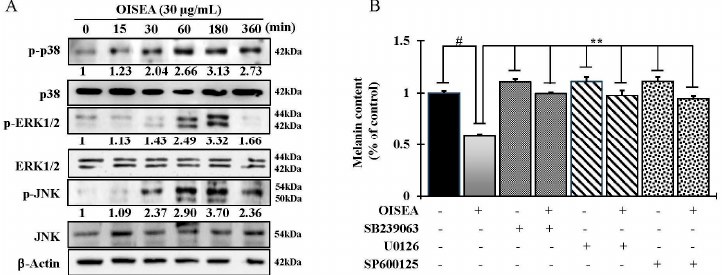
Figure 5. Effect of HLA on MAP kinase-dependent signaling in melan-a cells. ( A ) Cells (5 × 10 5 cells/mL) were cultured for 24 h, and the medium was replaced with fresh medium containing various concentrations of test compounds or arbutin for the indicated times. Phosphorylation of JNK, ERK, and p38 MAPK was analyzed using phospho-speci fi c JNK, ERK, and p38 MAPK antibodies. Equal protein loading was checked using β -actin antibodies. Numbers (each phospho-antibody) mean the relative band intensity. ( B ) OISEA was cotreated with selective inhibitors of p38 (SB239063), ERK (U0126), and JNK (SP600125) signaling molecules in melan-a cells. Melanin content was determined. Each determination was made in triplicate, and the data represent the means ± SD. # p < 0.05, ** p < 0.01, versus the control group.